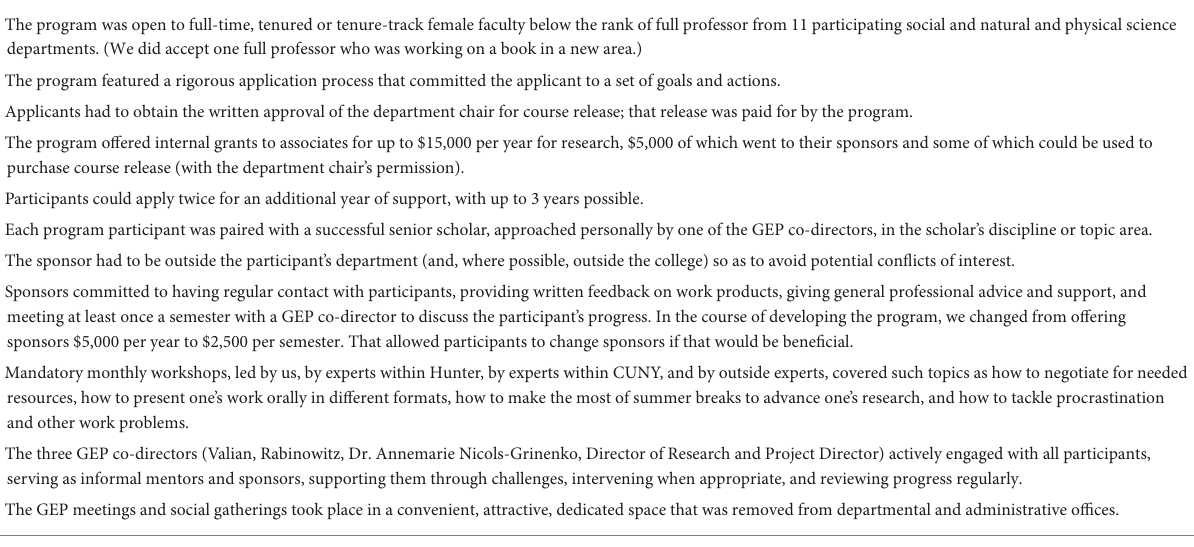
TABLE 1 Key elements of the Sponsorship